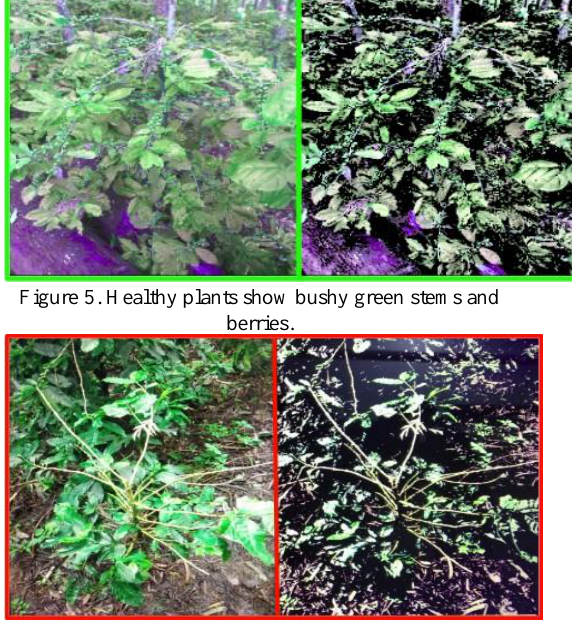
Figure 6. Unhealthy plants show prominent yellowing stems and leaner